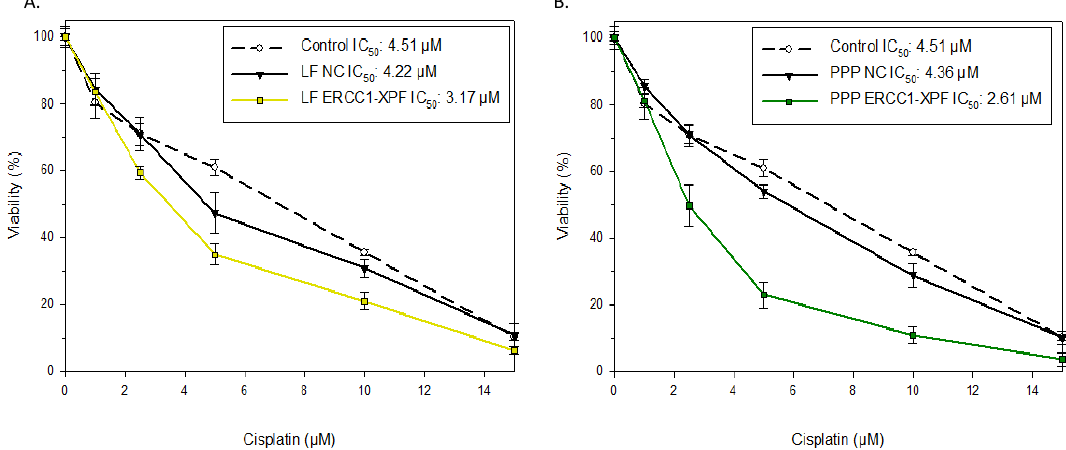
Figure 3. Colony survival assay in A549 cells following transfection with Lipofectamine 2000 ( A ) or PEI-PCL-PEG (PPP) micelleplexes ( B ). Untreated (open circle), negative control (filled triangles) or ERCC1-XPF (filled squares) siRNA transfected cells were treated with increasing doses of cisplatin for 2 h, and cell viability was determined by a clonogenic assay. Results are represented as mean ± SD. IC 50 values were calculated using Compusyn software.